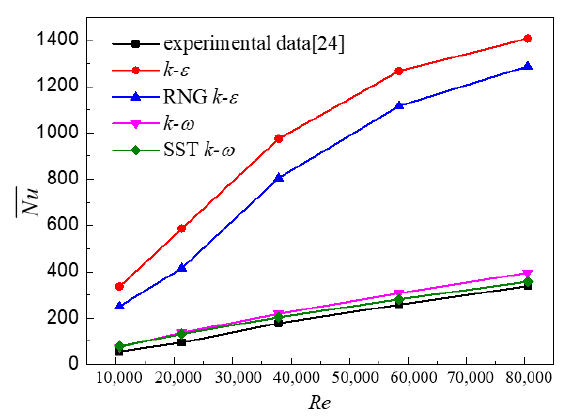
Figure 3. Turbulence model validation.